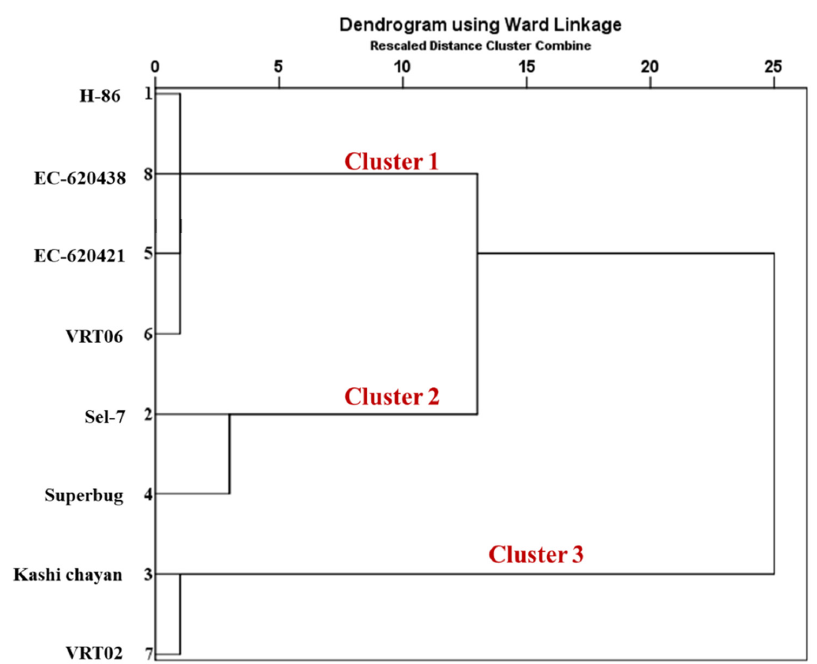
Table 3. Categorization of tomato cultivars based on cluster analysis.